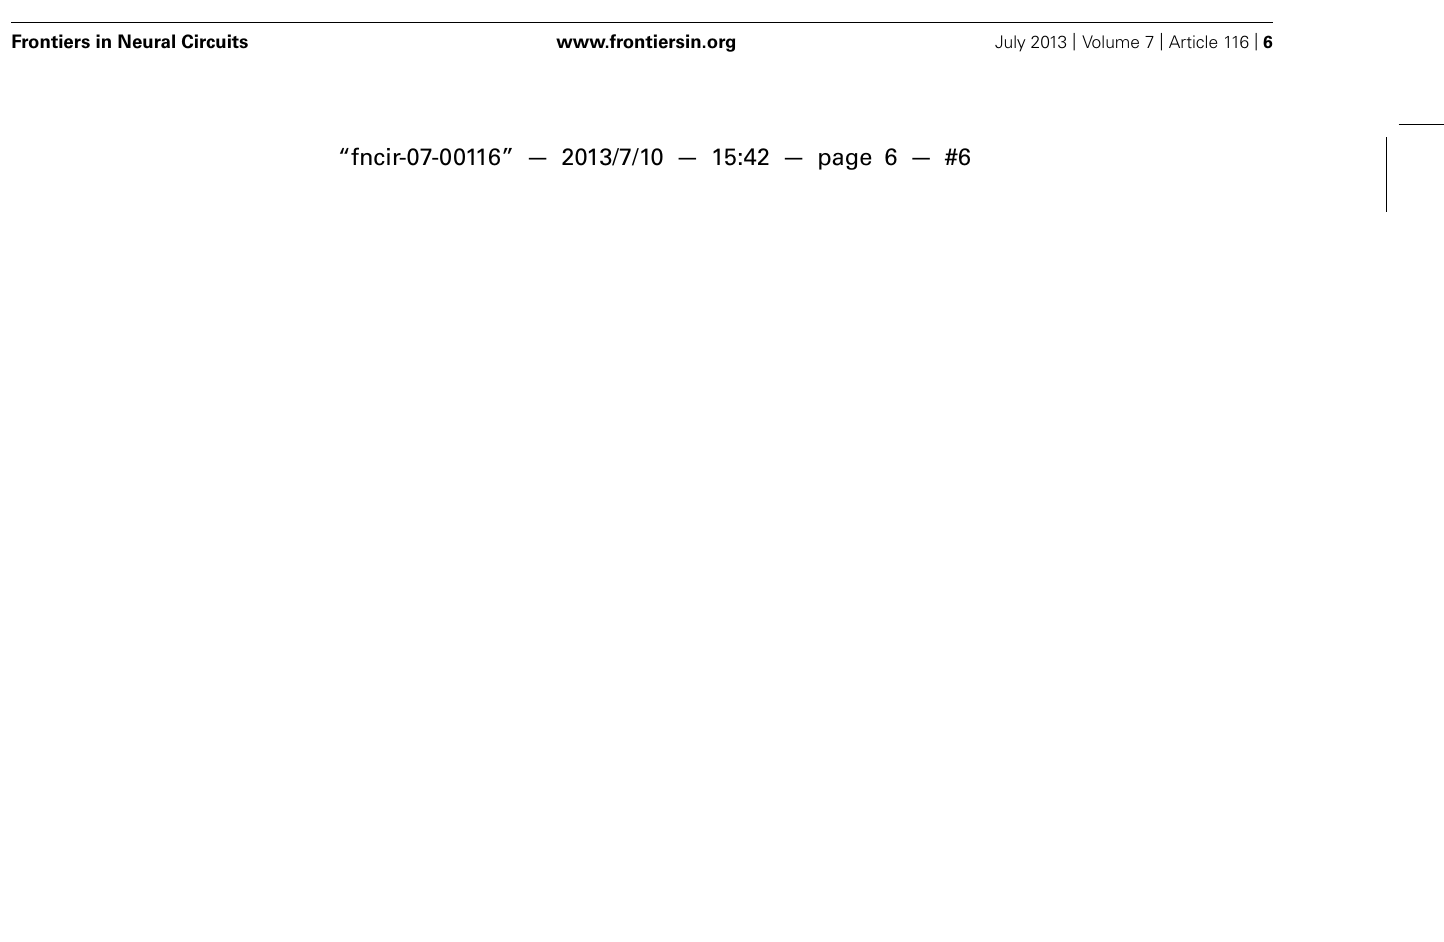
R in values of 79 and 49 M (cid:2) for resting and peak potentials of